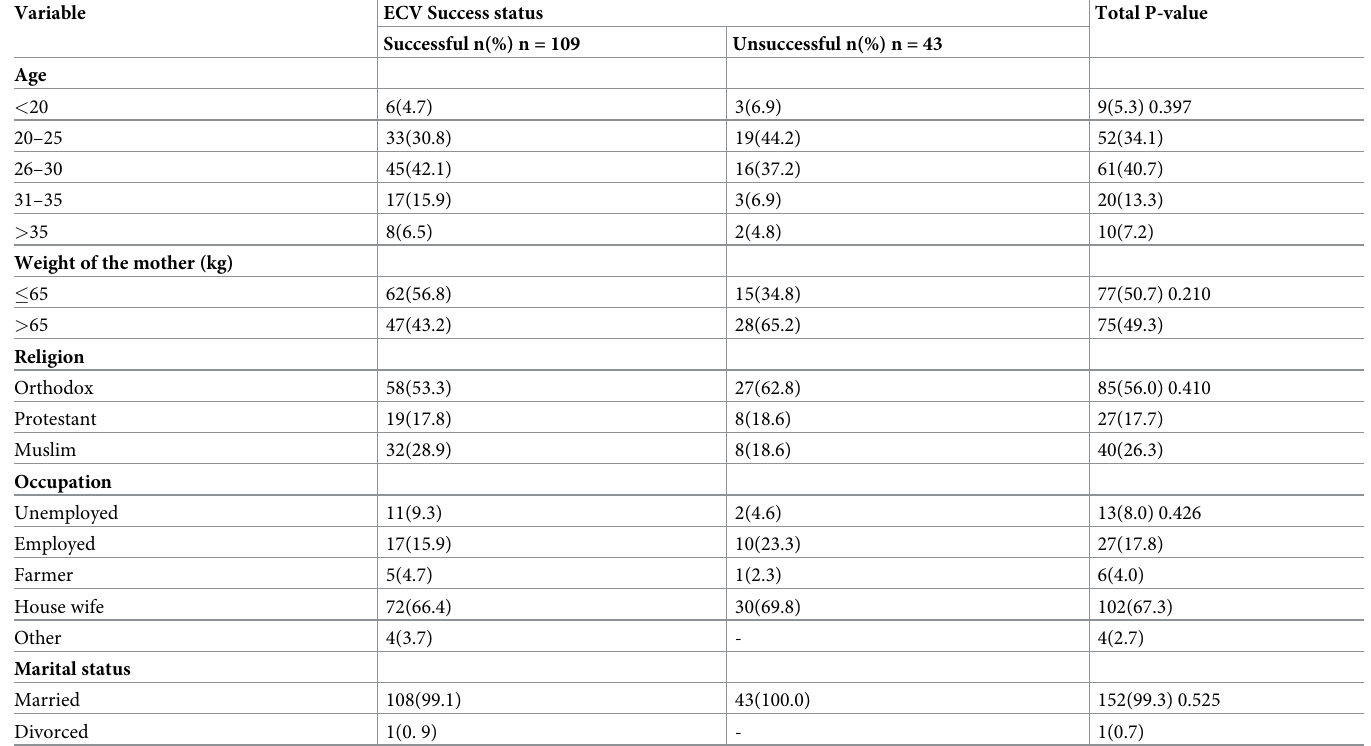
Table 1. Distribution of socio-demographic characteristics of study participants.